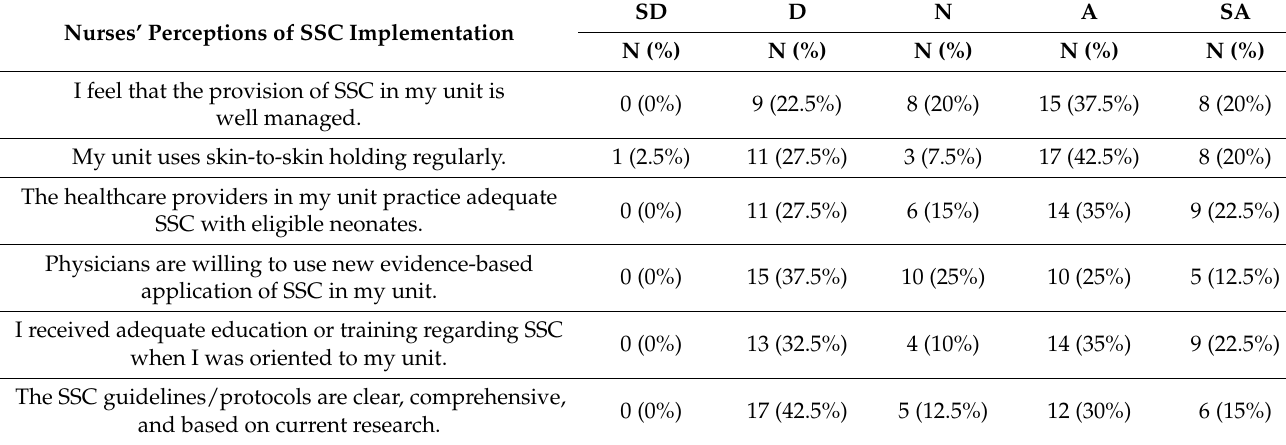
Table 4. Number and percentage of Likert-based responses on the nurses’ perceptions of SSC